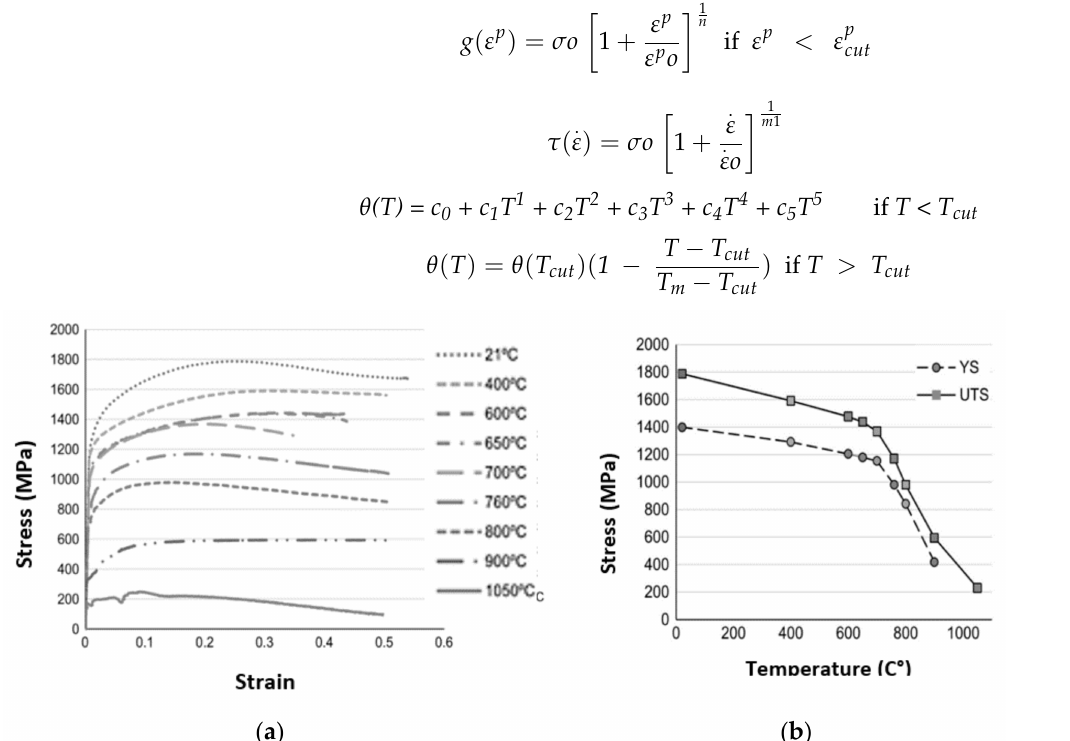
Figure 3. Flow stress behavior of Inconel 718 ( a ) Testing at various temperature at strain rate of 1 s − 1 ( b ) Thermal softening behavior (obtained from [25] with kind permission from